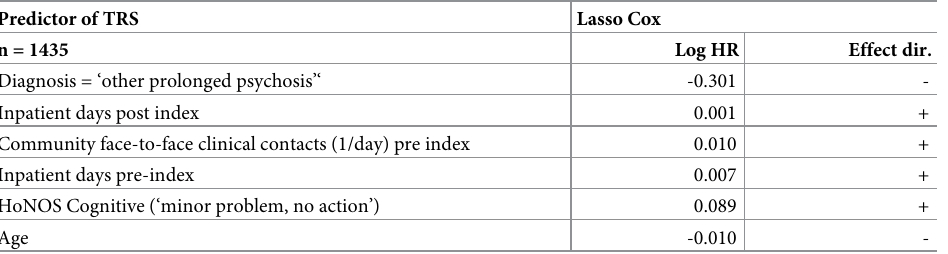
Table 2. Survival analysis Lasso Cox regression selected predictors (one standard error penalty).